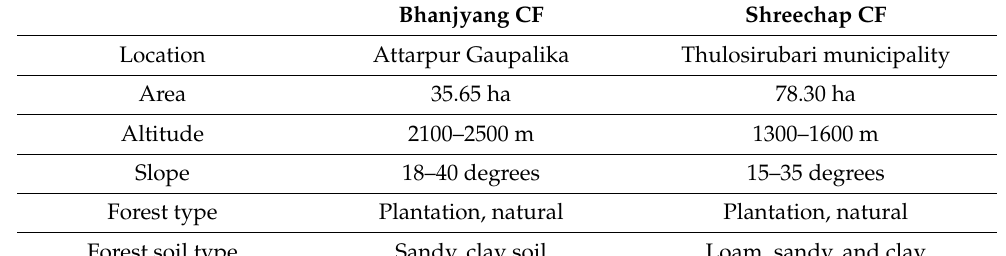
Table 1. Attributes of the two community forests.